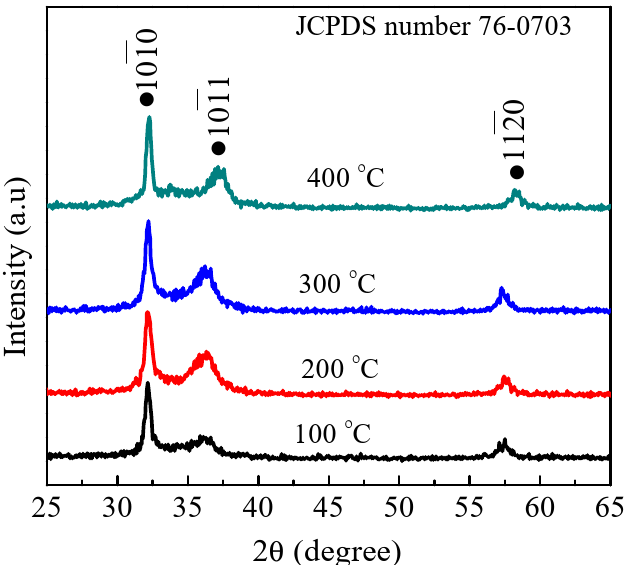
Figure 3. XRD patterns of SbGaN films deposited at heating substrate temperatures ranging from 100 to 400 °C.